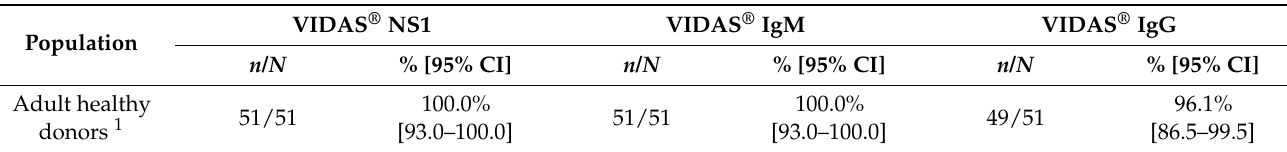
Table 7. Negative agreement of the VIDAS ® prototypes with the competitor ELISA tested on samples of healthy donors ( N =